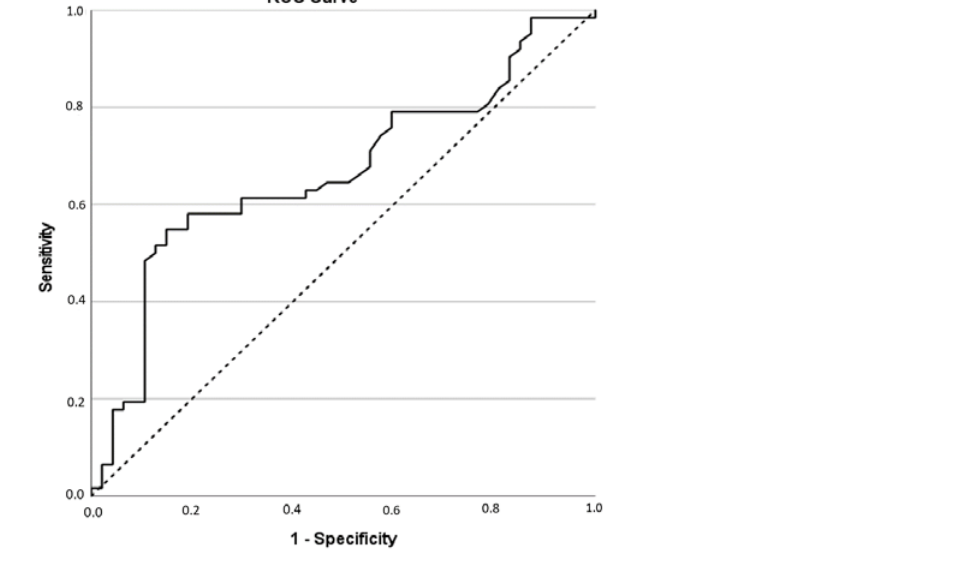
= 58.8%, accuracy = 67.9%) (The PSA level was <0.5 ng/mL in 57 patients; among them, 24